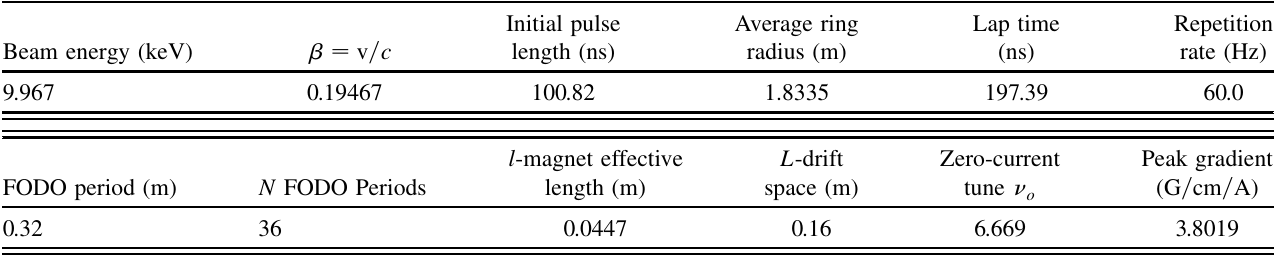
TABLE I. UMER main ring